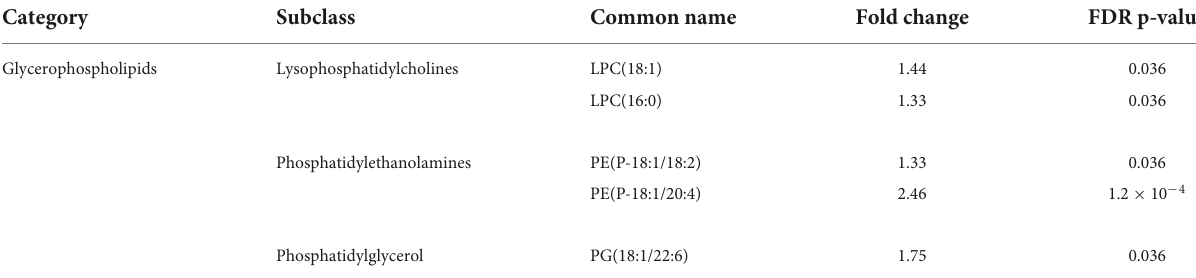
TABLE 1 Lipidomic changes after 2 h of isoprenaline (ISO)